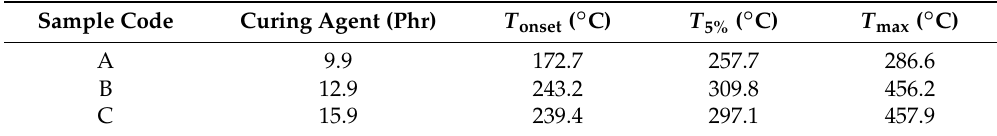
Table 3. Thermal stability characteristics of the samples obtained from TGA